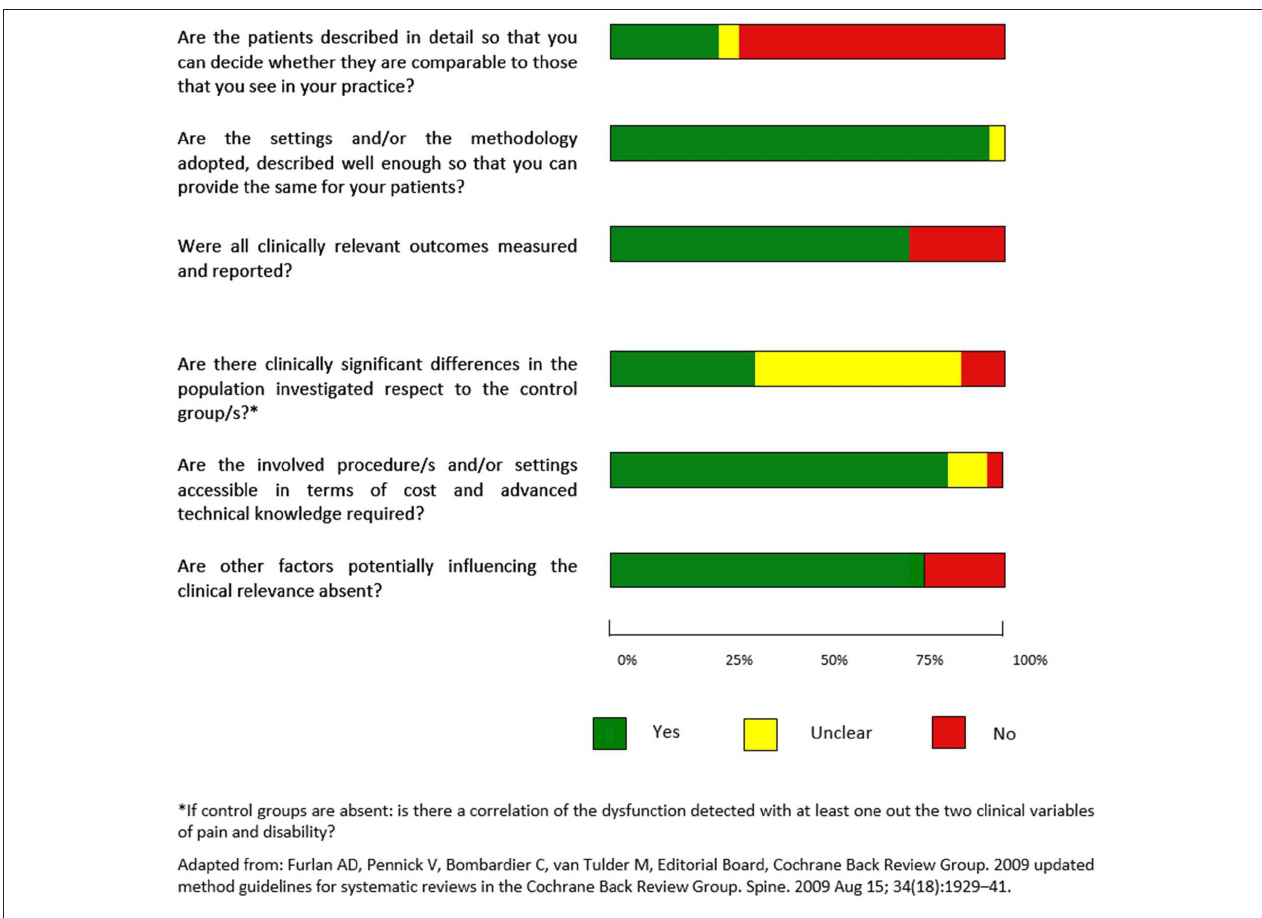
FIGURE 7 | Summary of the evaluation for clinical relevance of included assessment